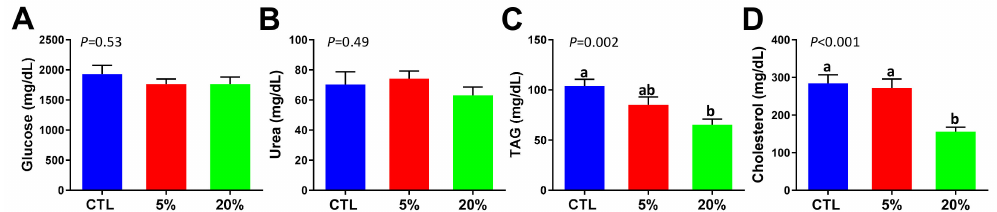
Figure 2. Influences of Scenedesmus feeding on blood biochemical analysis. ( A ) Serum glucose concentration. ( B ) Serum blood urea nitrogen (BUN) concentration. ( C ) Serum triacylglycerols (TAG) concentration. ( D ) Serum cholesterol concentration. P -values indicate overall significances across all sample groups from the one-way ANOVA test. The means with di ff erent letter labels (a,b) indicate significant di ff erences ( P < 0.05) between two dietary treatments by the Tukey post hoc